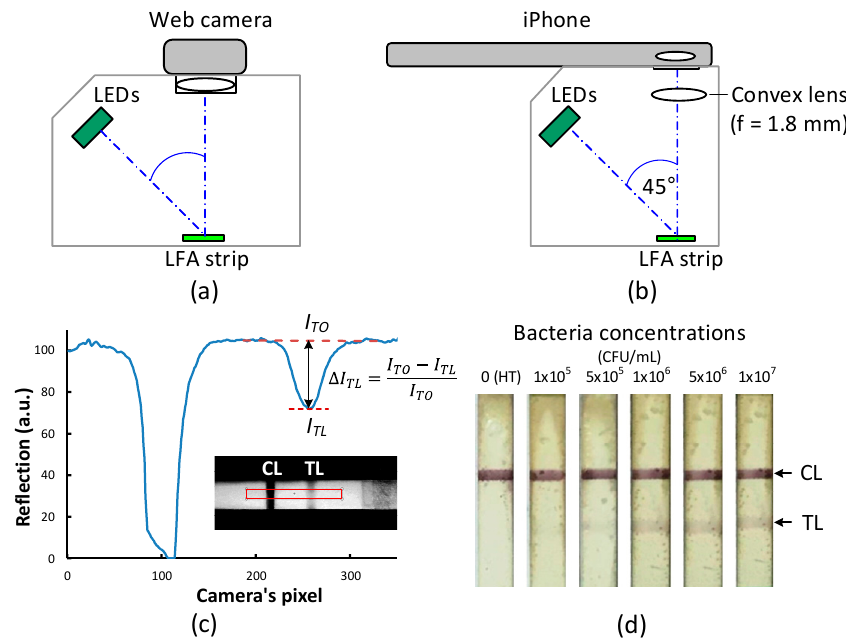
Figure 1. Schematic diagrams of the lateral flow readers using a web camera ( a ) and an iPhone ( b ) as a detection device. ( c ) Reflection line profile obtained from a LFA strip showing the intensity drops ( ∆ I TL ) at the control line (CL) and the test line (TL). ( d ) Color images of LFA strips after tested with various bacteria concentrations.